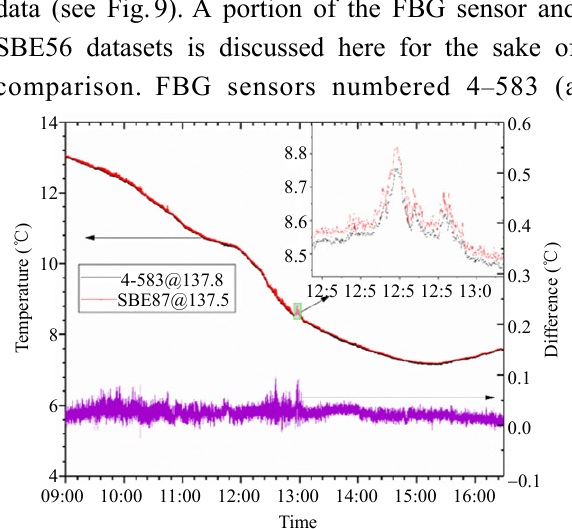
Fig. 9 Data comparison between the FBG temperature sensor numbered 4 ‒ 583 and the Sea-Bird Electronics 56 series’ temperature sensors temperature sensor numbered